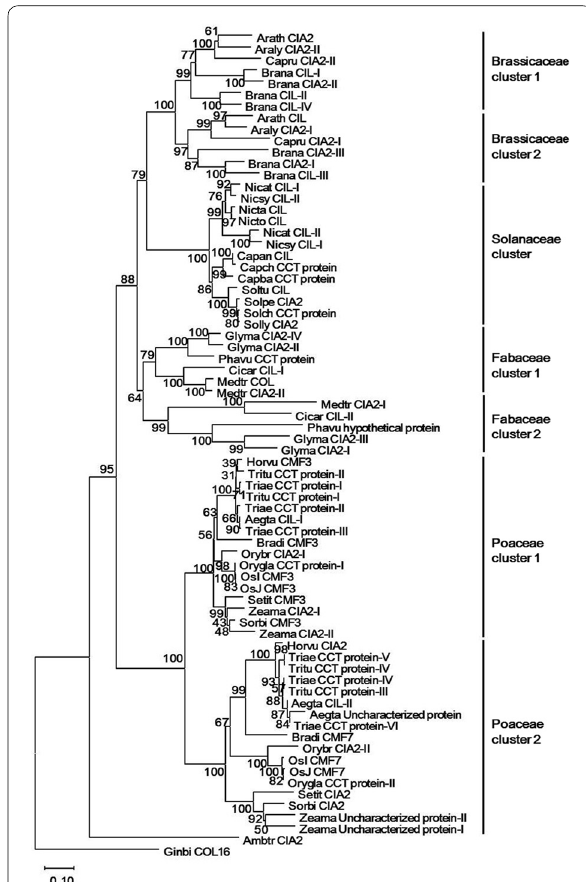
Fig. 6 Phylogenetic tree of 72 CIA2 and CIL protein homologs, generated by the MEGA‑X software using a Neighbor‑Joining approach with bootstrapping. Numbers at the roots of branches represent credible values obtained by performing 1000 bootstraps. Branch lengths have been drawn according to evolutionary distance, and the respective scale is shown in the lower left corner. Sequence details are provided in Supplementary Table